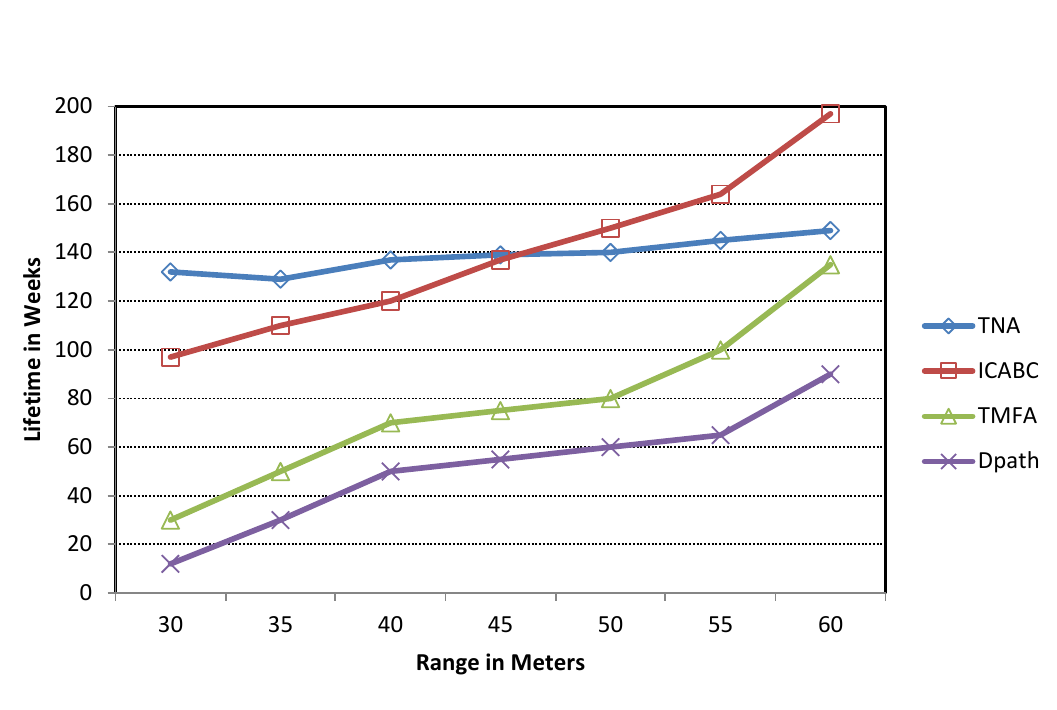
Figure 6. Lifetime versus network width